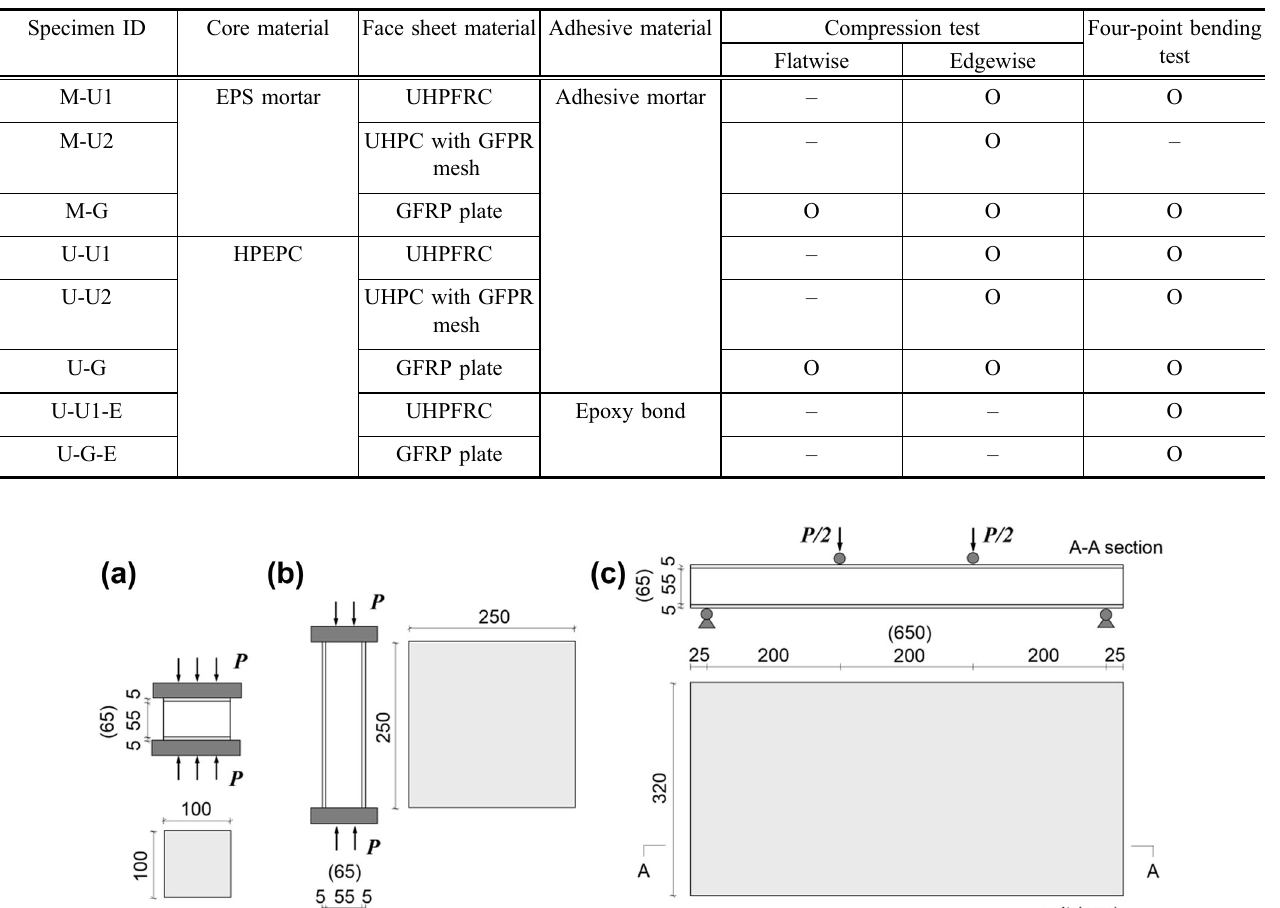
Table 4 Overview of test program for composite sandwich